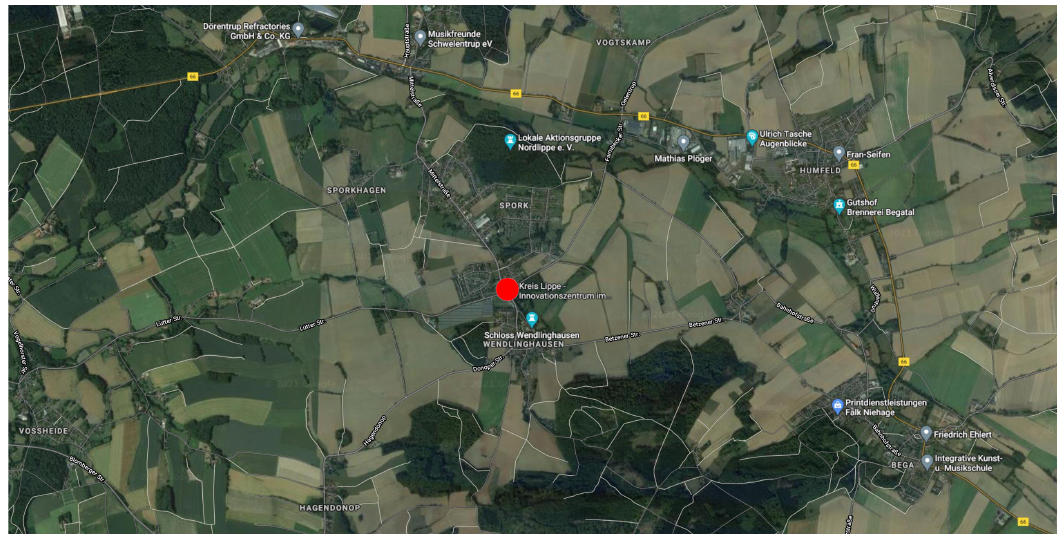
Figure A3. Lippe